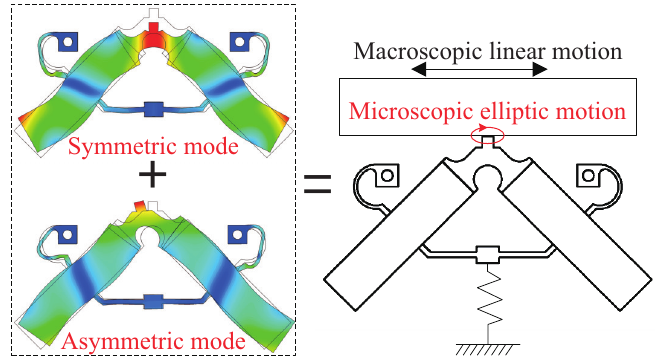
Figure 2. The operating principle description with the finite element